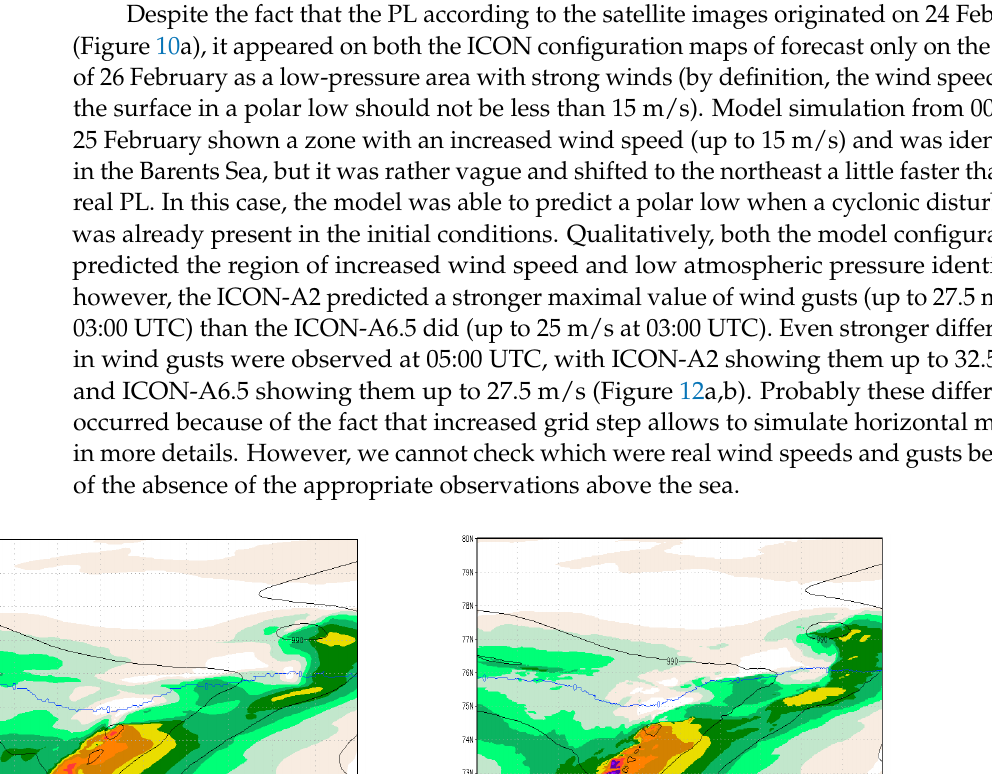
Figure 12. ICON ‐ A6.5 ( a ) and ICON ‐ A2 ( b ): wind gust simulations. Base time 00:00 UTC, valid time 05:00 UTC on 26 Figure 12. ICON-A6.5 ( a ) and ICON-A2 ( b ): wind gust simulations. Base time 00:00 UTC, valid time 05:00 UTC on